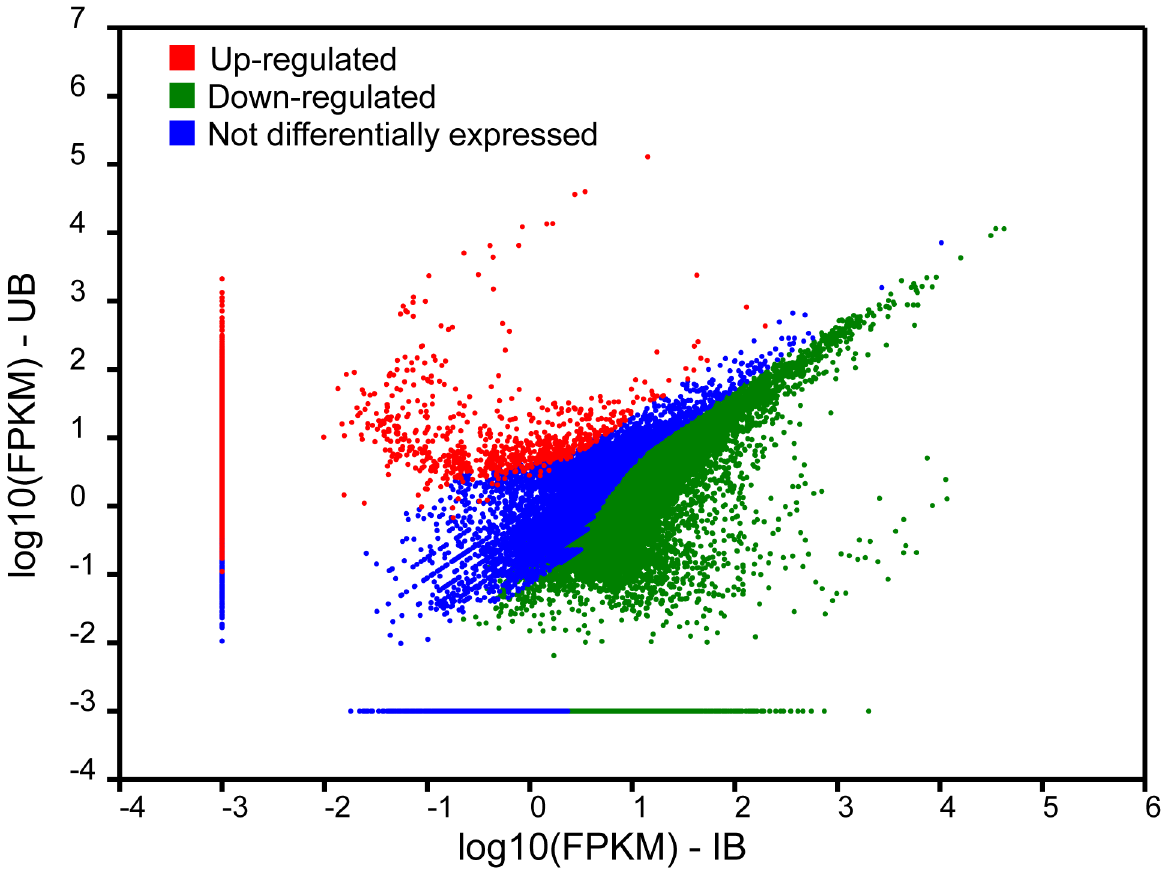
Figure 1. Scatter plot comparing log2 ratios of FPKM expression values for uninfected and Opisthorchisviverrini -infected Bithynia siamensisgoniomphalos snails (UB and IB, respectively).